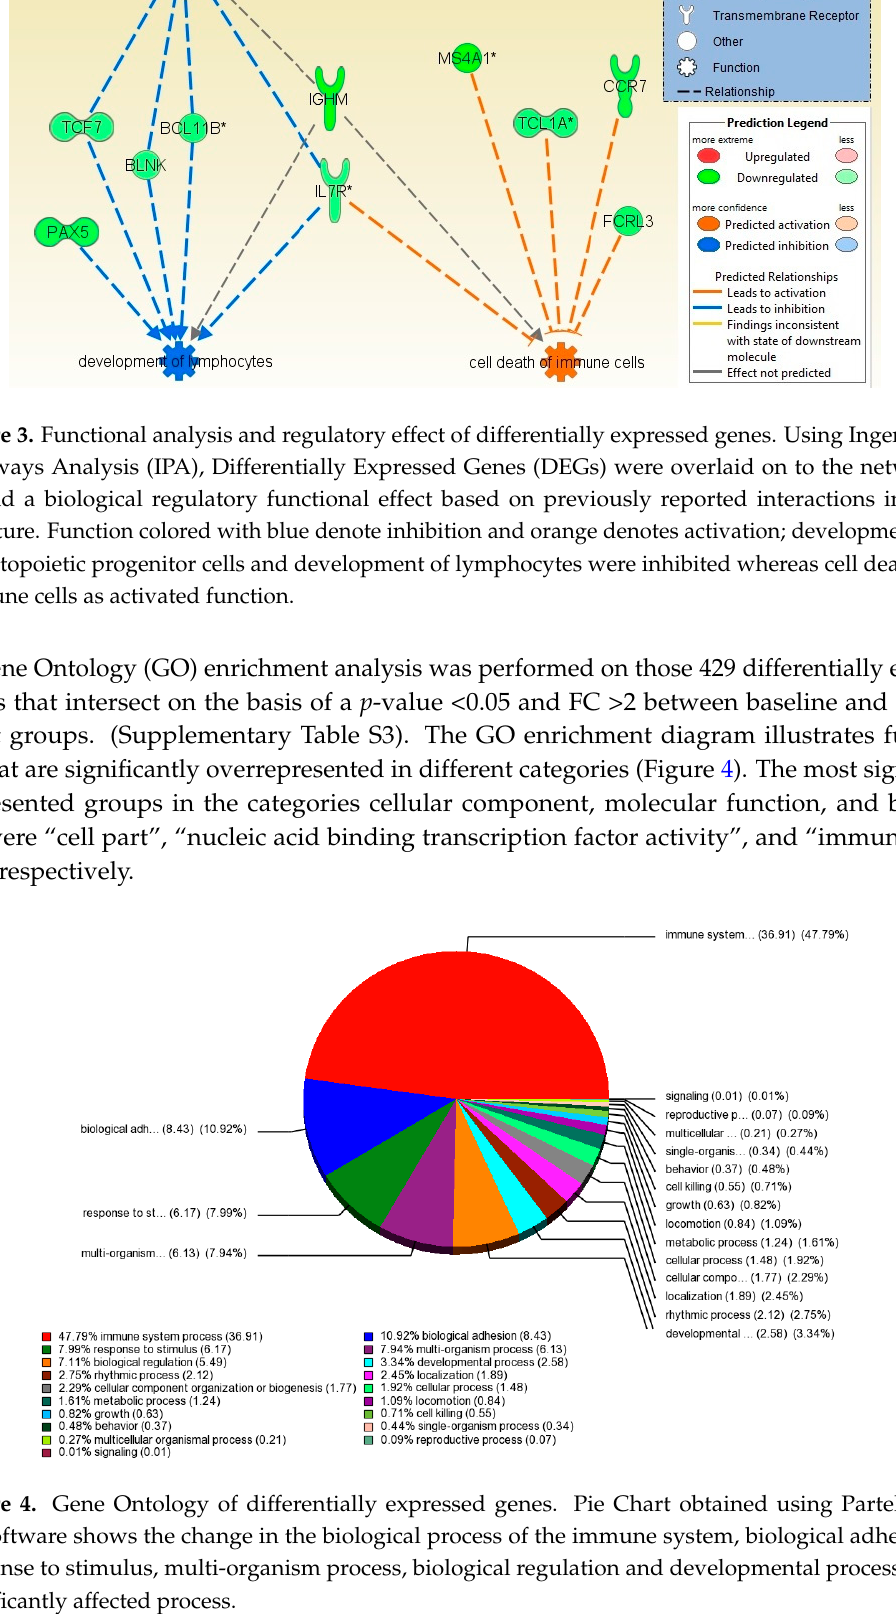
Figure 4. Gene Ontology of differentially expressed genes. Pie Chart obtained using Partek GS 6.6 software shows the change in the biological process of the immune system, biological adhesion, response to stimulus, multi-organism process, biological regulation and developmental process as a significantly affected process.